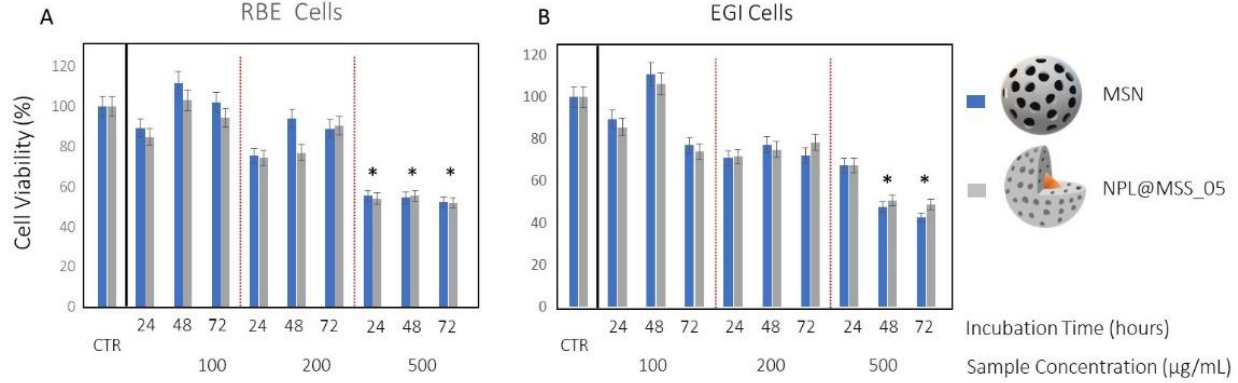
Figure 7. Cell viability tests on RBE ( A ) and EGI ( B ) cell lines treated with MSS and NPL@MSS_05 24. 48 and 72 h at the concentration of 100, 200 and 500 µg mL −1 . Control: untreated cells. * p < 0.05.